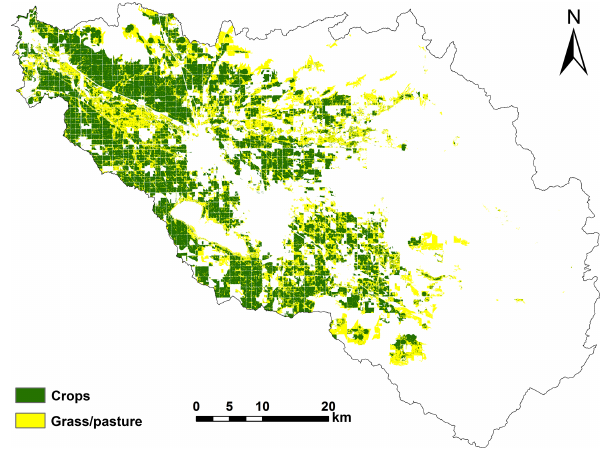
Figure 13. The spatial distribution of crops and grass/pasture in the agricultural area of the Treasure